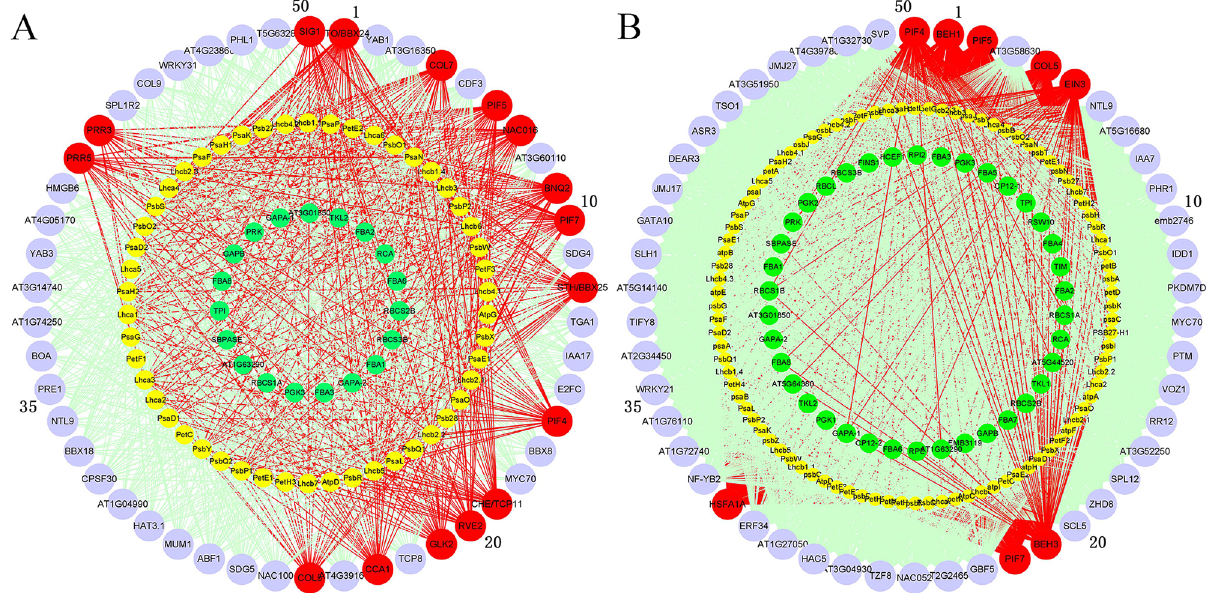
Figure 6. Gene regulatory network produced by triple-gene mutual interaction (TGMI) ( A ) and sparse partial least squares (SPLS) ( B ) algorithms for Arabidopsis thaliana light reaction and Calvin cycle pathway using the RNA-seq data generated from leaf tissues. The yellow nodes represent light reaction pathway genes. The green nodes represent Calvin cycle pathway genes. All other nodes are the top 50 transcription factors that have the highest connectivity to pathway genes regardless of their colors. The red nodes represent known positive regulatory genes that affect light reaction and Calvin cycle pathways while the red edges are to show the connections of a true positive known pathway regulator with pathway genes.